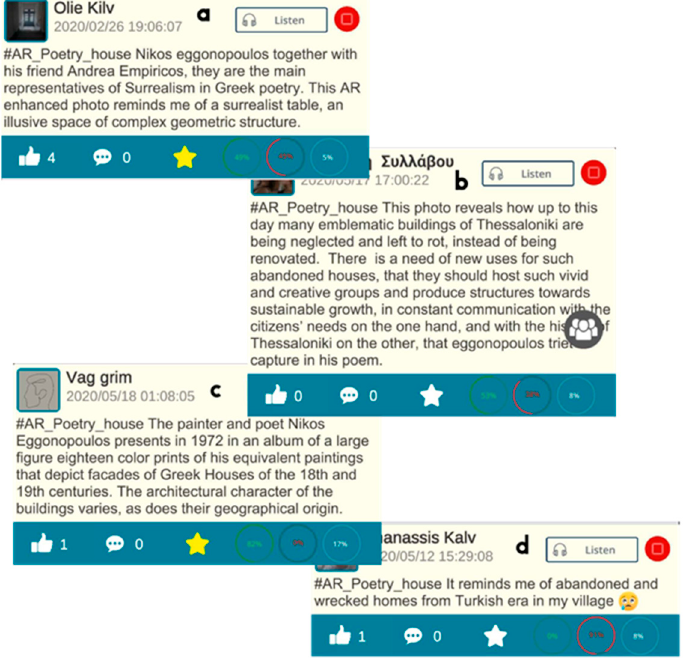
Figure 17. Examples of users’ posts shared regarding the selected AR photo exhibits.